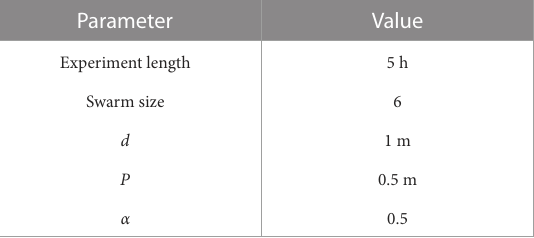
TABLE4 Parametervaluesformicroperspectiveexperiments.